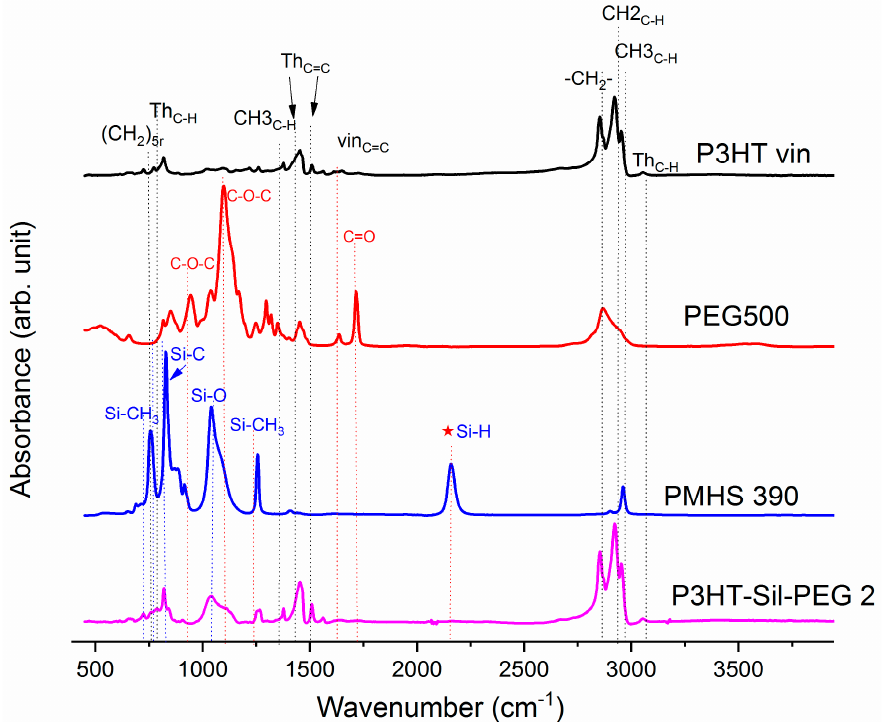
Figure 2. IR-ATR poly(methylsiloxane)-graft-poly(3-hexylthiophene)-graft-poly(ethylene glycol) (hexane fraction of vinyl terminated poly(3-hexylthiophene) P3HT-Sil-PEG2; poly(methylhydrosiloxane) trimethylsilyl terminated PHMS 390; poly(ethylene glycol) methyl ether methacrylate PEG 500.